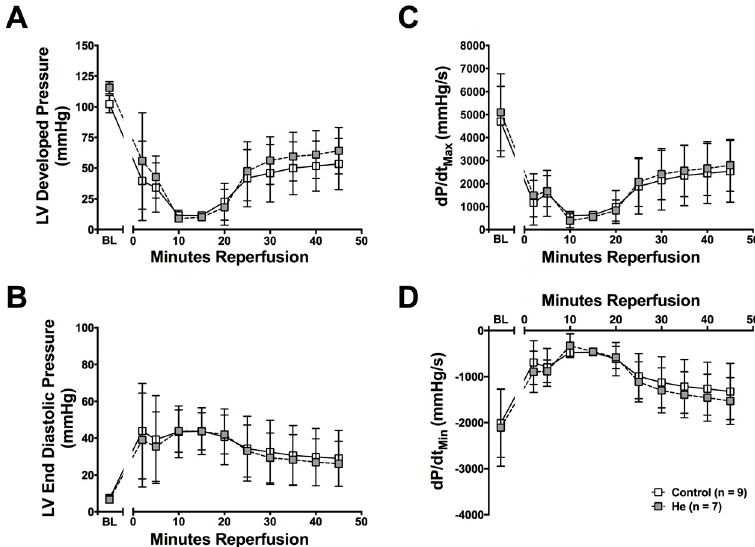
Figure 1. Langendor ff perfused hearts. Helium did not result in increased recovery after global ischemia in the Langendor ff perfused isolated heart 24 h after exposure. Cardiac function was measured as ( A ) left ventricular developed pressure (LVDP), ( B ) left ventricular end diastolic pressure (LVEDP), ( C ) contractility (dP / dt max ) and ( D ) lusitropy (dP / dt min ). Data are presented as mean ± standard deviation (SD) ( n = 7 for helium, n = 9 for control) and results were considered significant when p < 0.05.